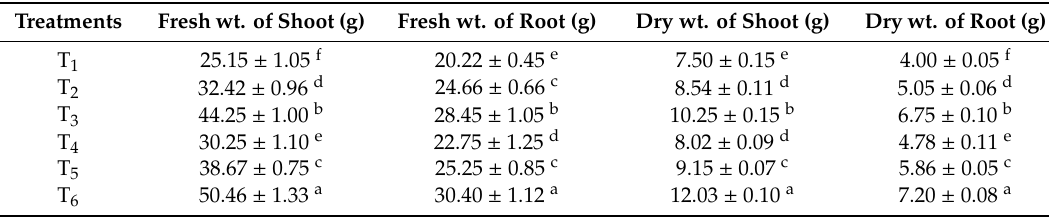
Table 2. Effect of seed biopriming with P. aeruginosa MF-30 on plant biomass accumulation in maize at 30 DAPI under nethouse conditions.